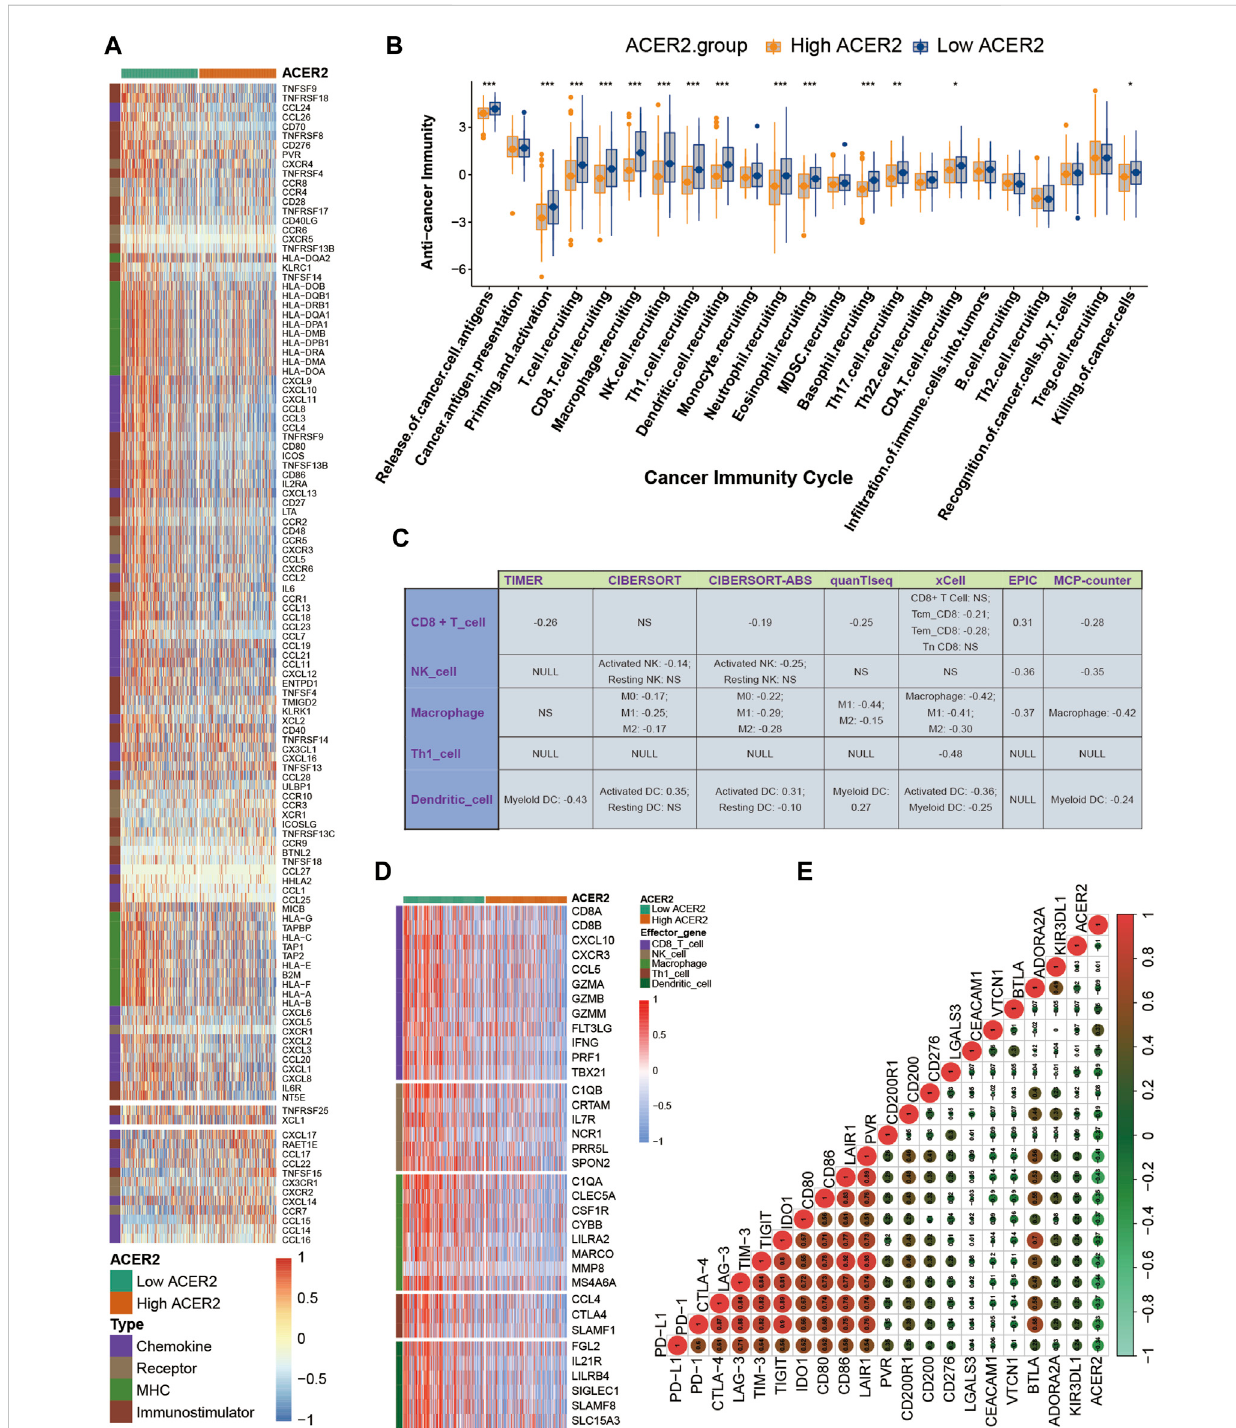
FIGURE 3 ACER2correlatedwiththetumorimmunemicroenvironmentinBLCA. (A) DifferentialexpressionofACER2betweenhigh-andlow-ACER2tissuesin BLCA. (B) Differential expression of ACER2 among various steps of the anti-tumor immune cycle. (C) Correlation between ACER2 and the in fi ltration levels of fi ve TIICs with various algorithms. (D) Differential expression of effector genes of fi ve mentioned TIICs between high- and low-ACER2 tissues in BLCA. (E) Correlation betweenACER2 and 20 inhibitory immune